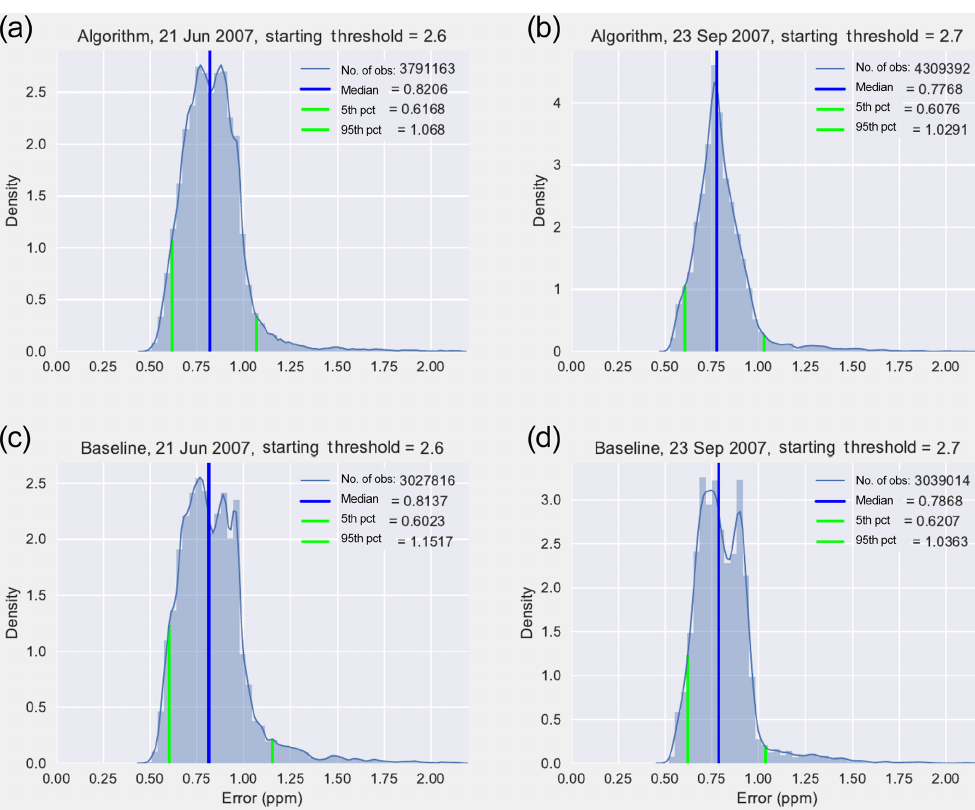
Figure 8. Global error distribution, baseline strategy (c, d) , and algorithm-selected strategy (a, b) .